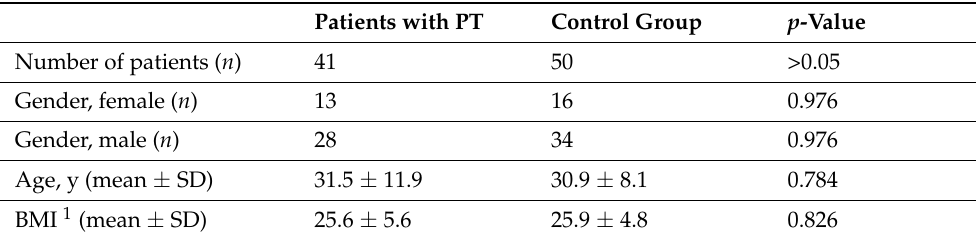
Table 1. Patient-related data. Patients with PT Control Group p -Value Number of patients ( n